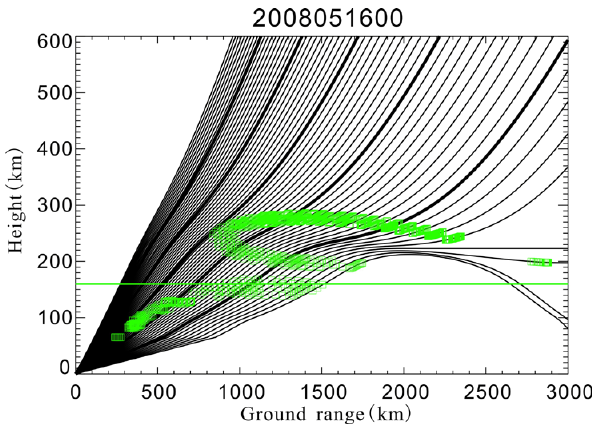
Fig. 2. Simulated ray path plot. The traces correspond to elevation angles from 1 ◦ to 29.5 ◦ ; the rays with elevation angles of 5 ◦ , 10 ◦ , 15 ◦ , 20 ◦ , 25 ◦ are illustrated by thick lines. The green squares plot- ted on the rays indicate that the rays are within 1 ◦ of normality to the Earth’s magnetic field. The green dashed line corresponds to 160km height. The simulation is done for Hankasalmi radar beam 9.